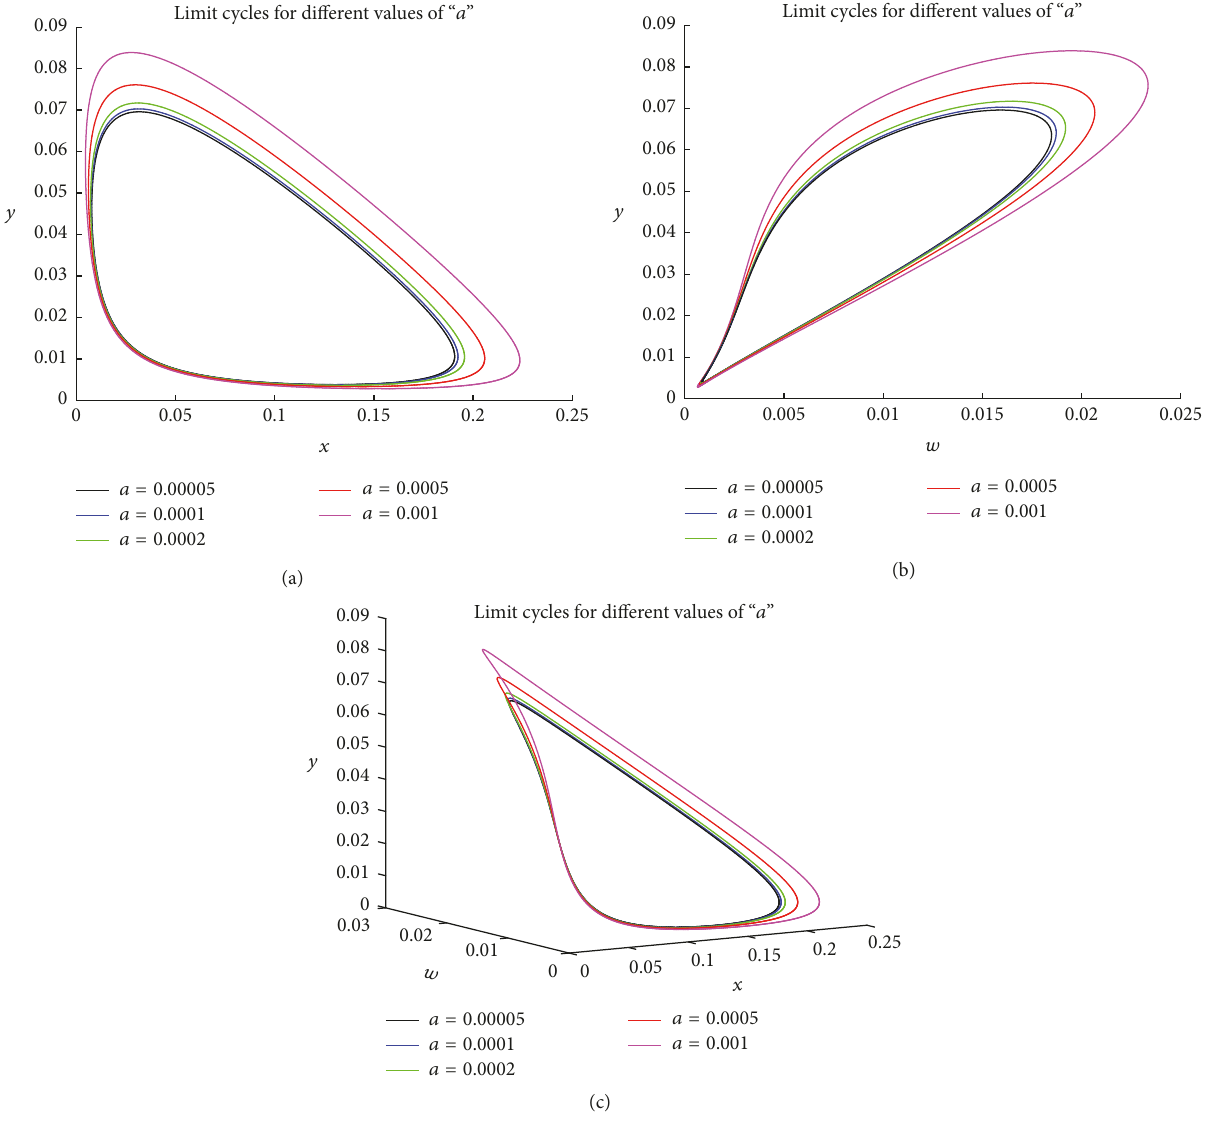
Figure 6: Stable cycles generated by supercritical Hopf bifurcation in 𝑥𝑦 (𝑆𝐼) , 𝑤𝑦 (𝐸𝐼) planes and in 3 D (𝑆𝐸𝐼) , respectively, for (𝑟,𝜀,𝑚,𝑠,𝛾,𝜎,𝛽) = (10 −4 ,10 −3 , 0.5, 1.2, 0.0548, 0.24, 0.46825) , 𝛼 ∈ [5 ⋅ 10 −5 , 10 −3 ] , determined by a custom orthogonal collocation on finite elements algorithm. min 𝛽 cr = 0.51825 ( 𝛼 = 5 ⋅ 10 −5 ). Periods: 𝑇 min = 410.414990 days ( 𝛼 = 5 ⋅ 10 −5 ); 𝑇 max = 441.550487 days ( 𝛼 = 10 −3